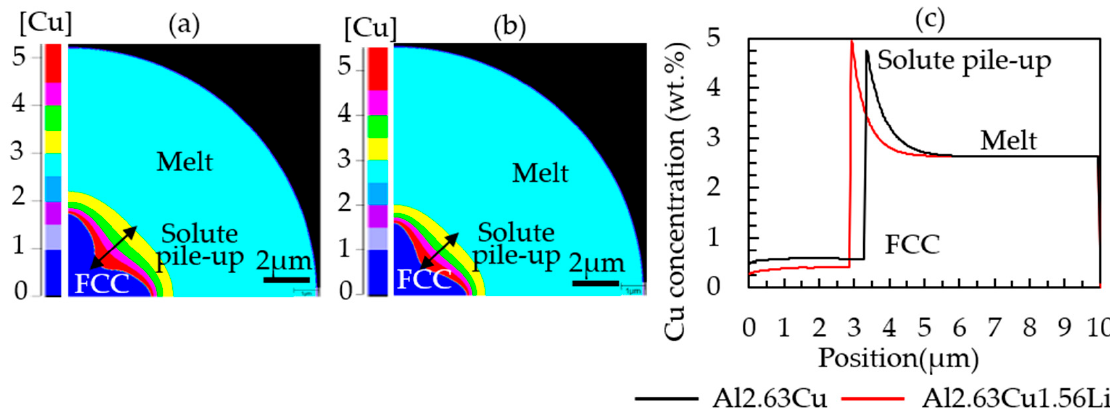
Figure 6. Diagram showing the copper pileup (in wt.%) ahead of the solid–liquid interface at simu ‐ lation time 0.0004 s during droplet solidification of ( a ) Al ‐ 2.63Cu and ( b ) Al ‐ 2.63Cu ‐ 1.56Li, and ( c ) comparison along the Z direction from cell 1 to 500. ( c ) comparison along the Z direction from cell 1 to 500.